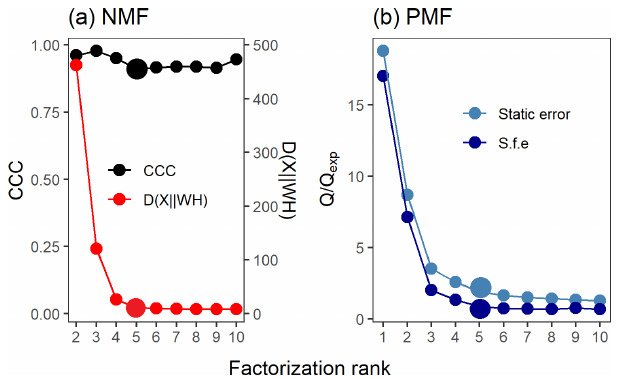
Figure 2. Factor number indices for gas-phase data (PTR-MS). Es- timation of the factorization rank for NMF in (a) , with CCC and D ( X || WH ), and for PMF in (b) , with Q/Q exp for the two error schemes (static error and signal following error – S.f.e). Larger points indicate the solution that was selected for more detailed in-